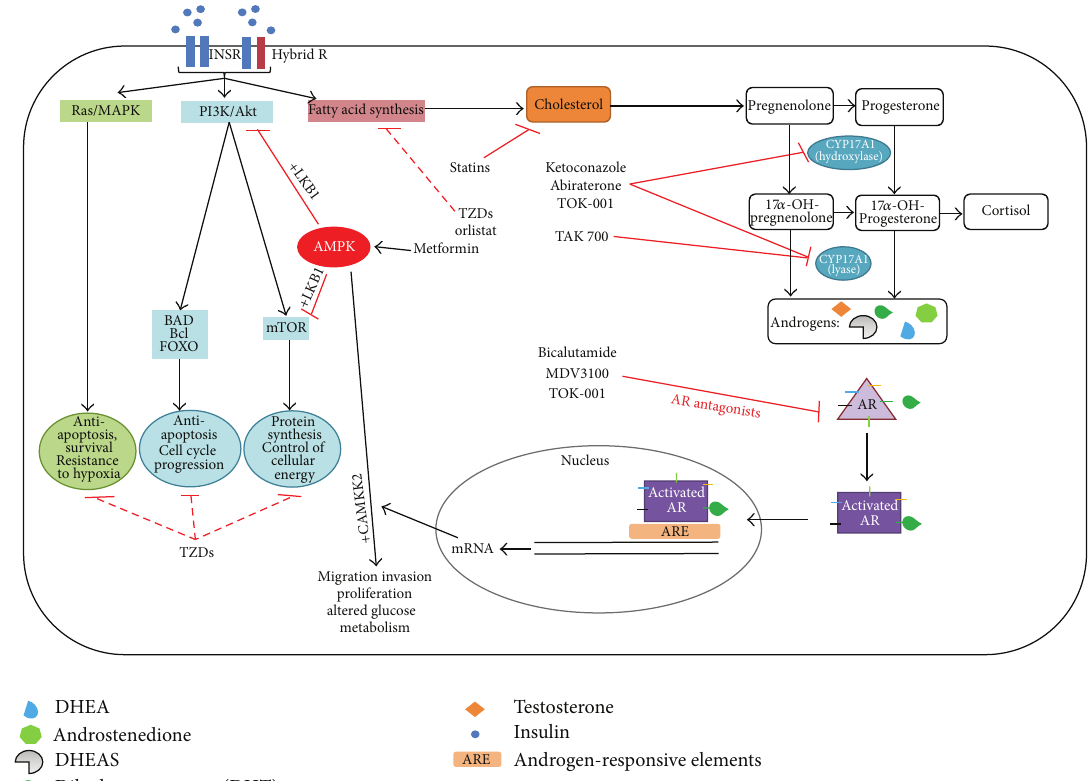
Figure 1: Therapeutic regimens combining insulin-sensitizing drugs and androgen-signalling inhibitors may be beneficial for treating prostatecancerprogressionfollowingADT.AndrogensignallingistargetedusingdirectARinhibitors.Bicalutamide(Casodex)andMDV3100 directly bind AR to prevent activity. Ketoconazole, abiraterone (Zitega), and TOK-001 have dual inhibition of CYP17A1 lyase/hydroxylase activity. In addition TOK-001 directly blocks AR activity. TAK-700 inhibits CYP17A1 lyase activity only and may not require concomitant control of rise in mineralocorticoids as is needed for abiraterone. Hyperinsulinaemia would be expected to increase insulin signalling in prostate cancer cells. Insulin can accelerate de novo androgen synthesis [153], which provides the AR with several suitable ligands (Key) and allows AR-mediated transcription of genes needed for CRPC progression. Additionally, insulin signalling may activate several AR- independent pathways (e.g., antiapoptosis and cell proliferation). Insulin-sensitizing drugs, such as metformin, orlistat, thiazolidinediones, and statins effectively block insulin-induced effects such as proliferation, lipid, and cholesterol synthesis and, hence, may be effective for the treatment of prostate cancer. The role of AR on AMPK-mediated cell response is still unclear and may be dependent on availability of cofactors (LKB1 versus